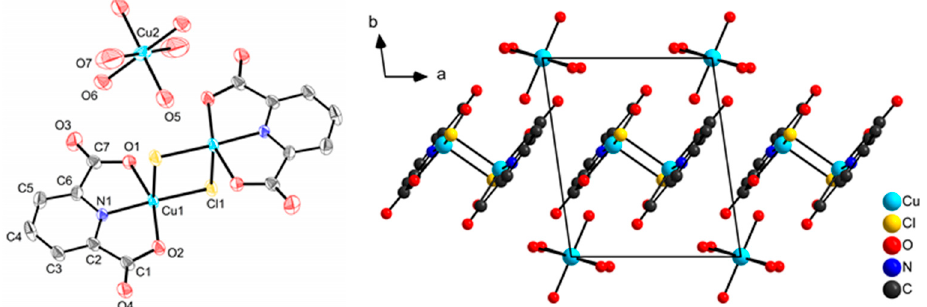
Left: ORTEP representation (50% probability level) of the molecular structure of [Cu(OH 2 ) 6 ][{Cu(pydic)} 2 (µ-Cl) 2 ]. H atoms were omitted for clarity. Right: Crystal structure of